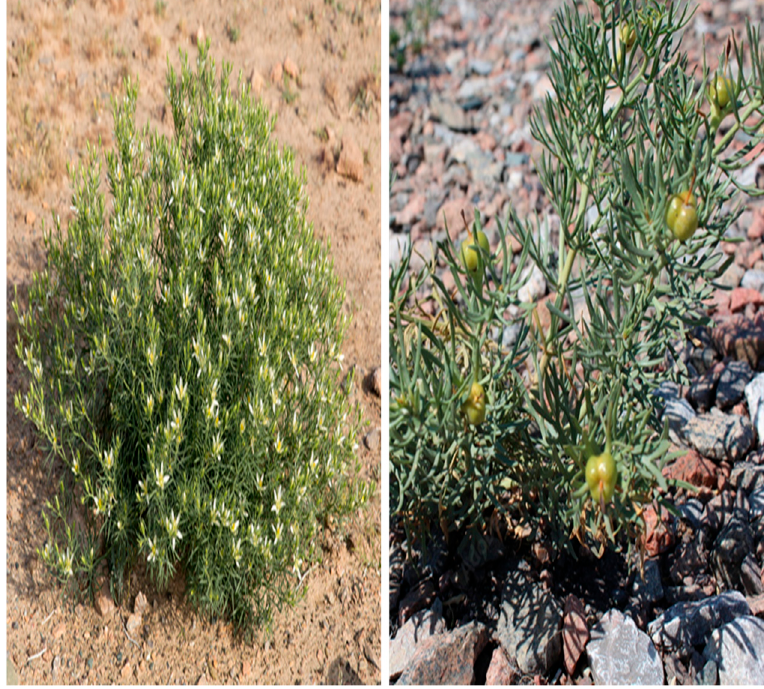
Figure 1. Peganum harmala .